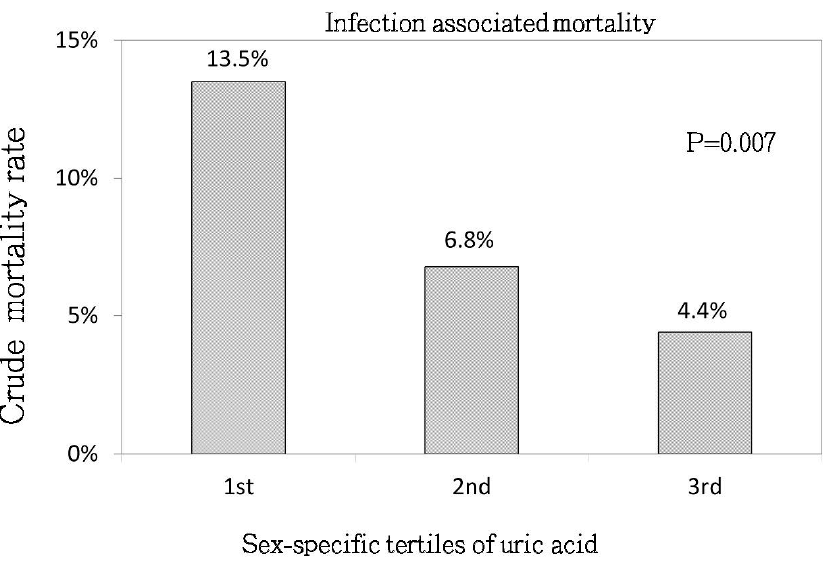
Figure 3. Crude analysis of infection-associated mortality rate between the sex-specific tertiles of serum uric acid levels ( p = 0.007).